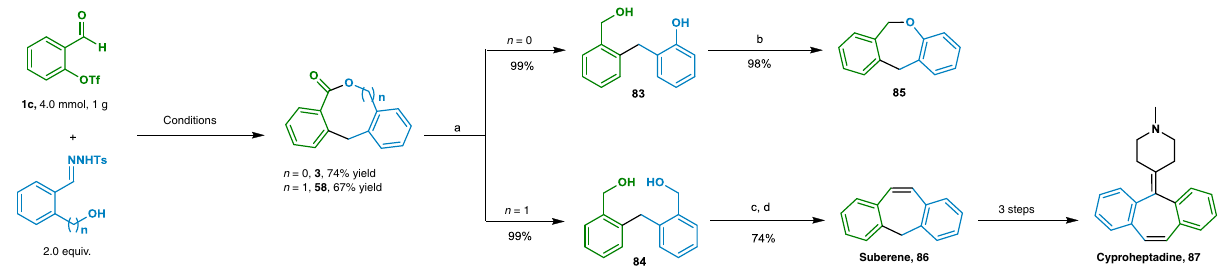
Fig. 4 Synthetic manipulations. Reagents and conditions: a LiAlH 4 , THF, 0 °C, 3 h; b Ph 3 P, diethyl diazene-1,2-dicarboxylate, toluene, 70 °C, 6 h; c DMP, t BuOH, DCM, RT, 5 h; d TiCl – 80 °C, 6 4 , Zn, pyridine, THF, 0